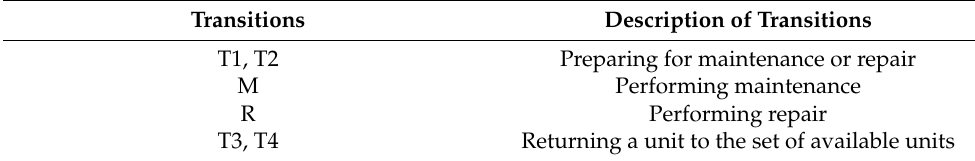
Table 5. Transitions of MR